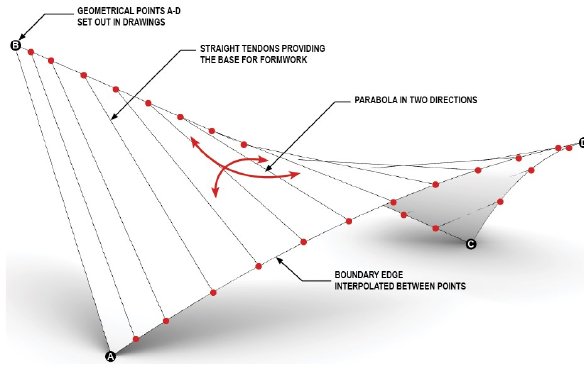
Figure 10: Overview geometry of Hyperbolic Paraboloid shell